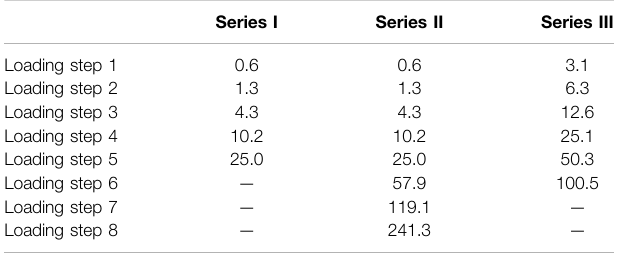
TABLE 3 | IL tests loading plan